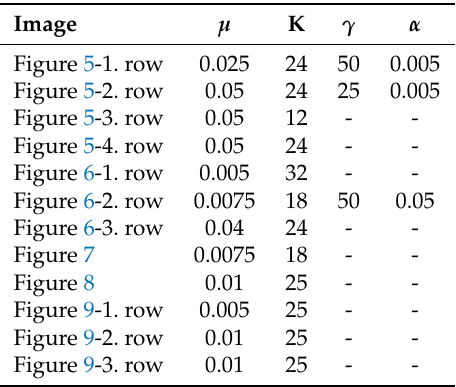
Table 1. Parameters for our numerical